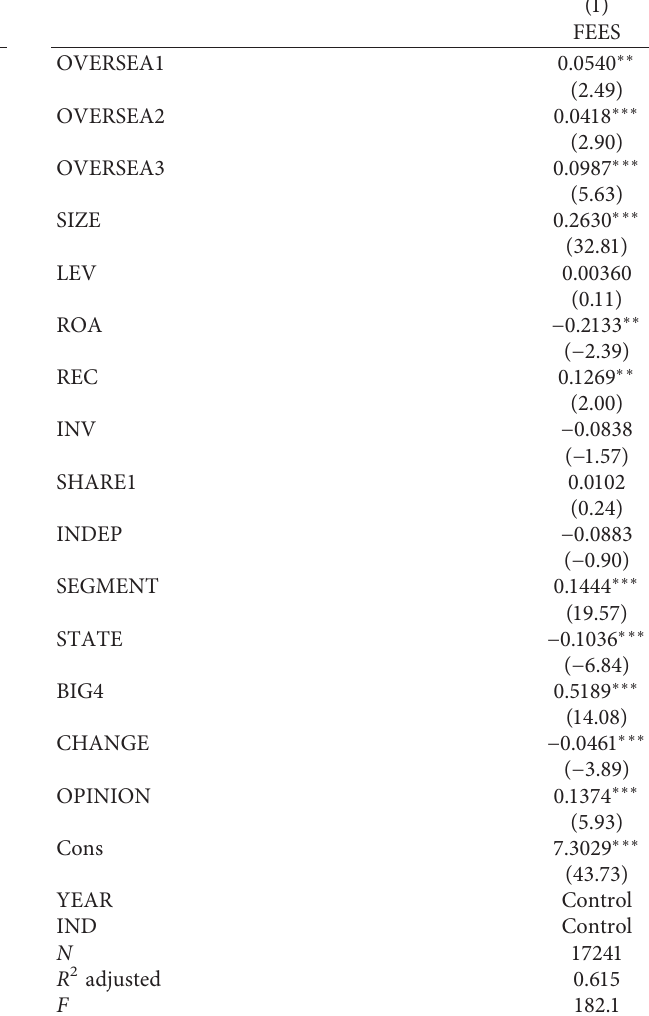
Table 8: Marketization process, audit committee overseas expe- rience, and audit fees.